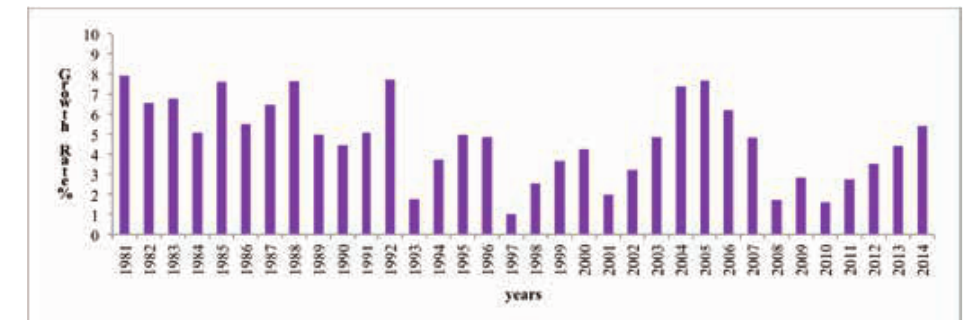
Figure 1: Trend of Economic